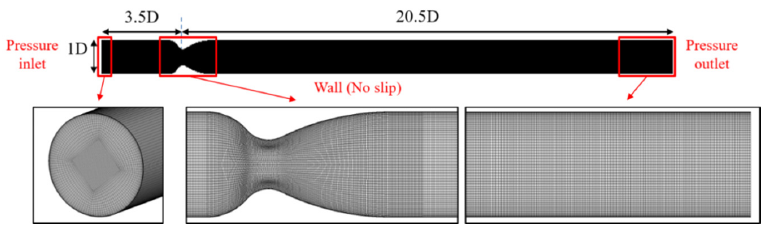
Figure 6. Grids in physical domain for pipe flow for three-dimensional (3D) steady CFD simulations with applied boundary